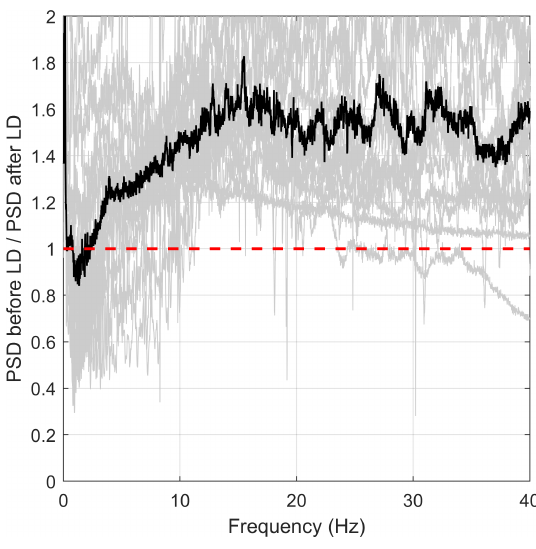
Figure 8. Ratios between the spectra computed before and during the lockdown (grey lines; see Fig. 7) and the corresponding stacked ratio (black line). The red horizontal dashed line indicates a ratio value equal to